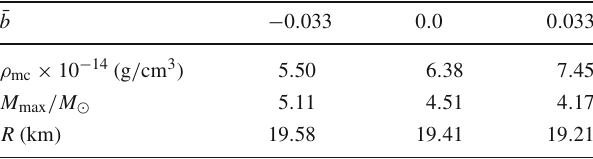
Table 2 The maximum mass and corresponding radius for three-form field stiff-fluid stars in the presence of a Higgs-type potential for ¯ a = 0 . 003, and different values of ¯ b